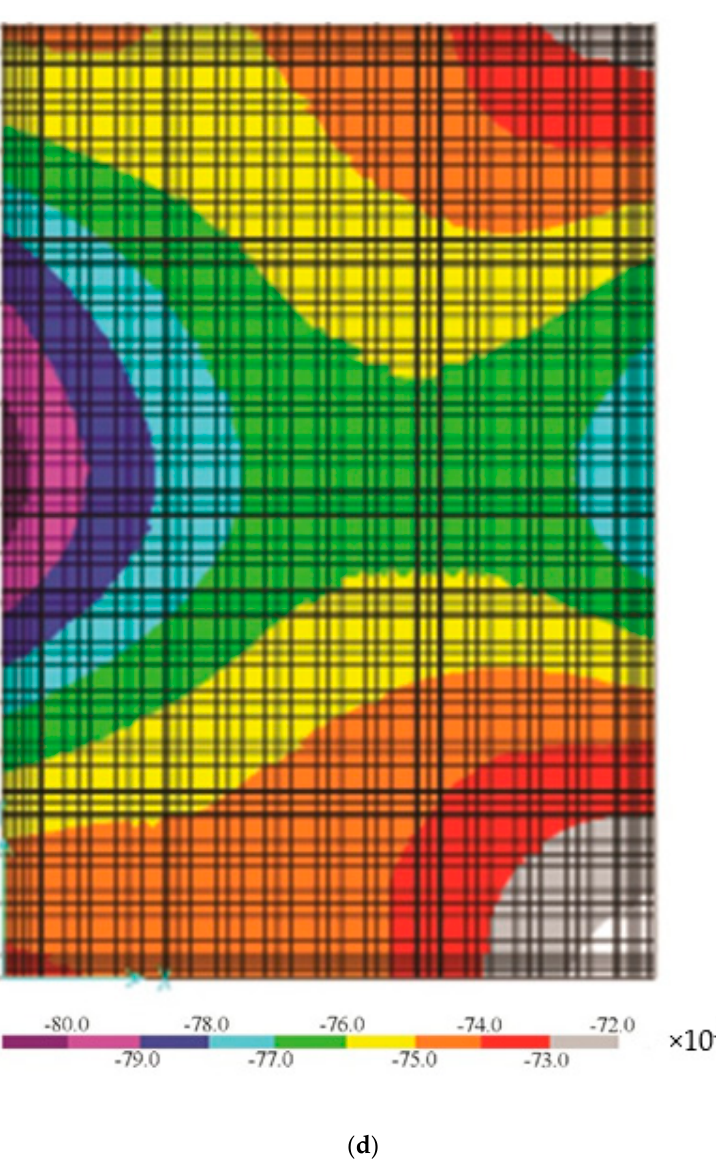
Figure 6. Deformation of the eight-story building with type 2 load ( a ) structure, ( b ) foundation in ANSYS, ( c ) foundation (with the constant Ks ) in SAFE, ( d ) foundation (with variable Ks ) in SAFE.